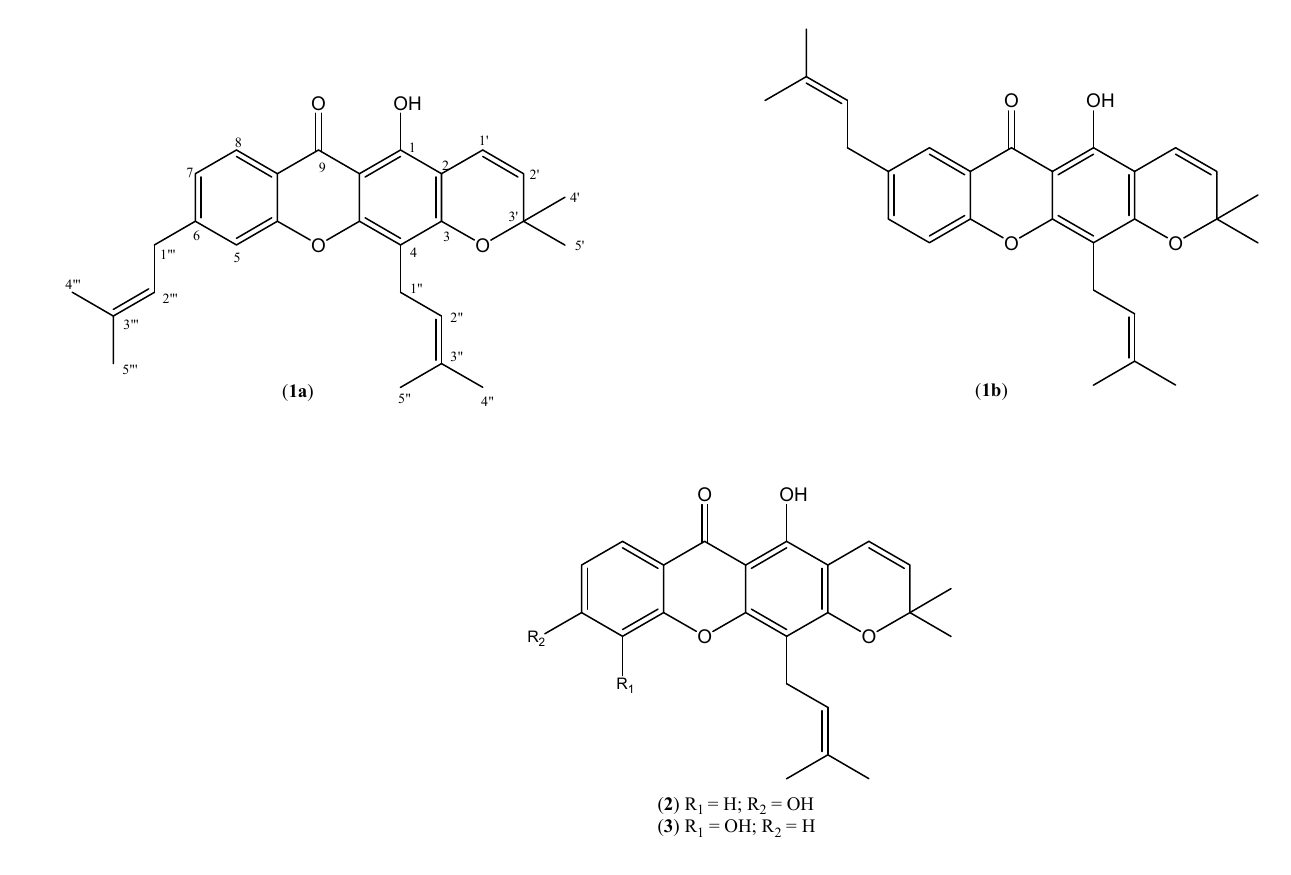
Figure 1. Structures of compounds 1a , 1b , 2 , 3